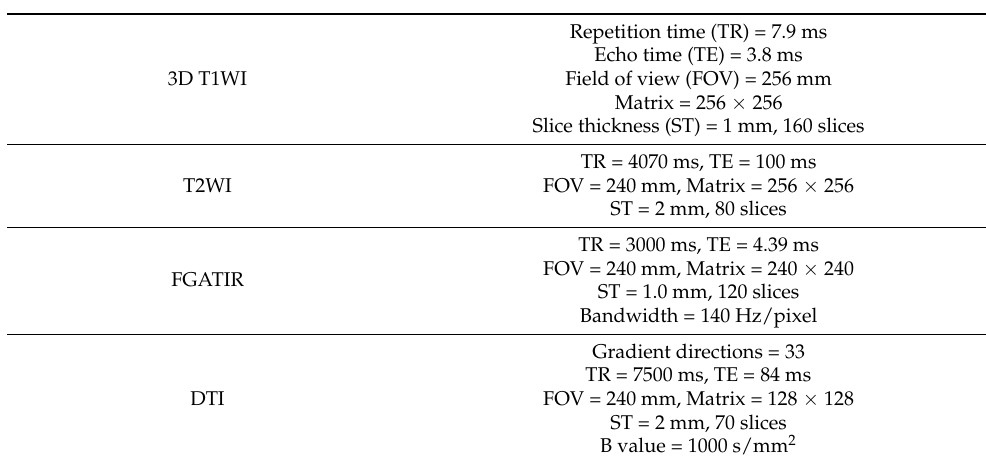
Table 2. Parameters of preoperative